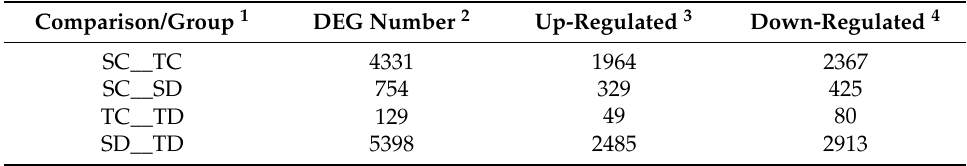
Table 3. Expression patterns of the differentially expressed genes (DEGs) by group.